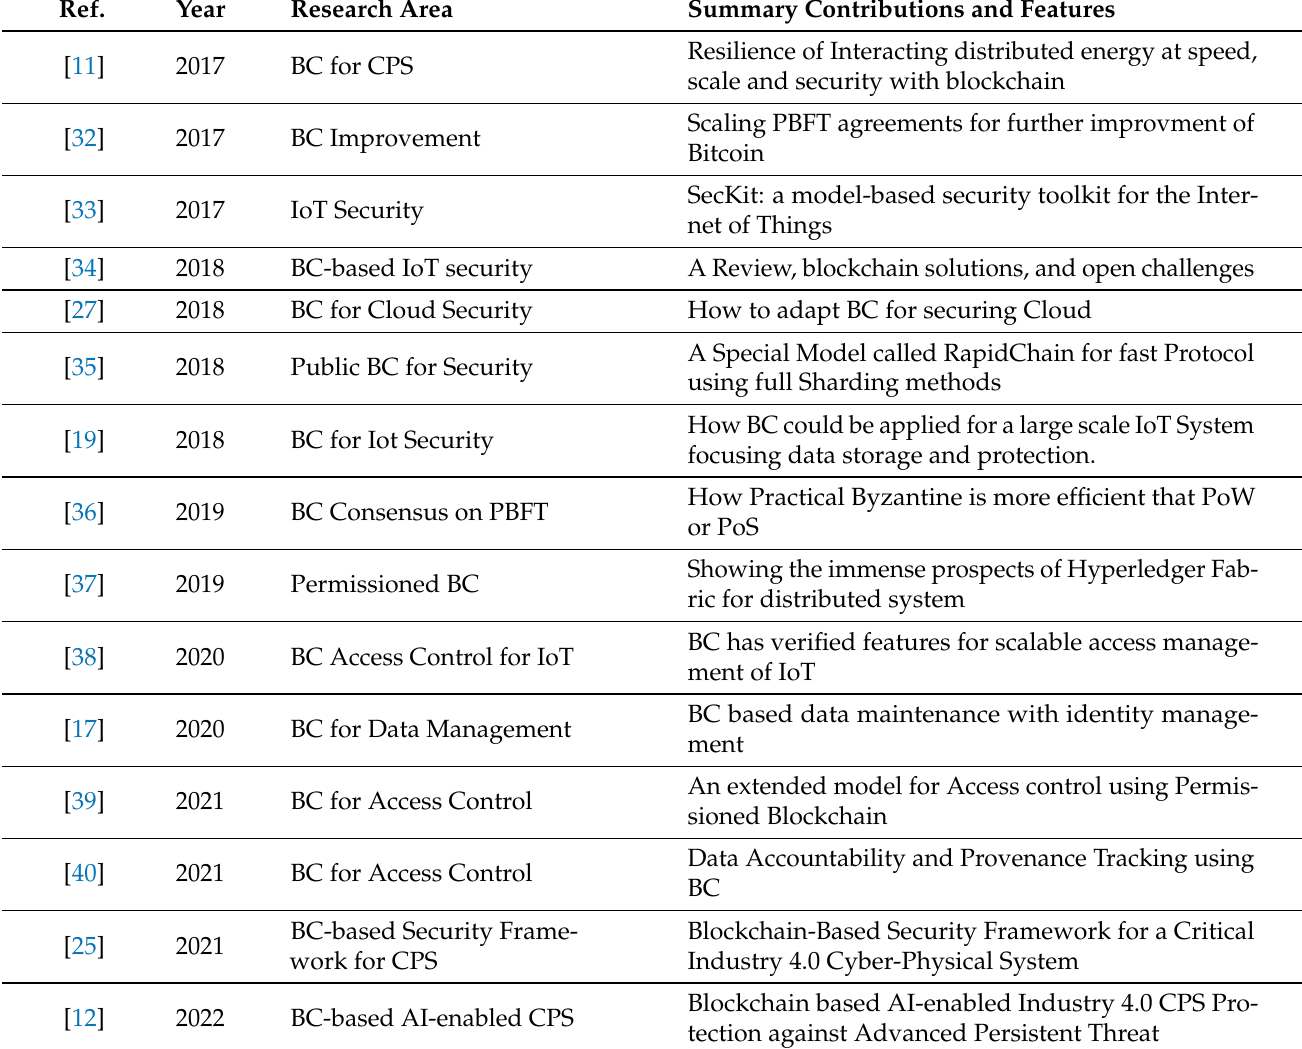
Table 1. Overview of the selected recent literature reviews on BC and BC-based IoT applications.